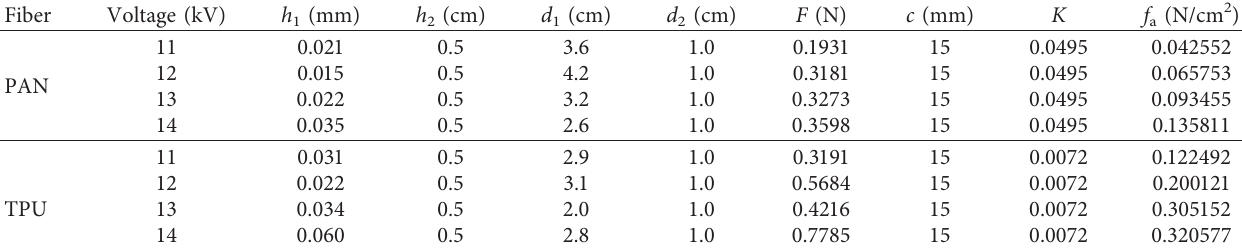
Table 3: Adhesion of different fibers.